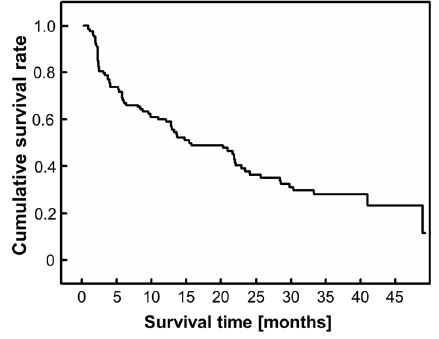
Figure 2. Kaplan–Meier survival curve.